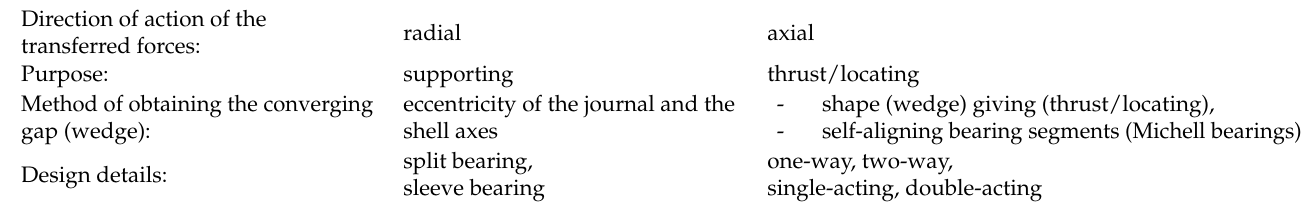
Table 1 presents the classification of machine set rotor slide bearings. Table 1. Classification of the machine set rotor slide bearings.